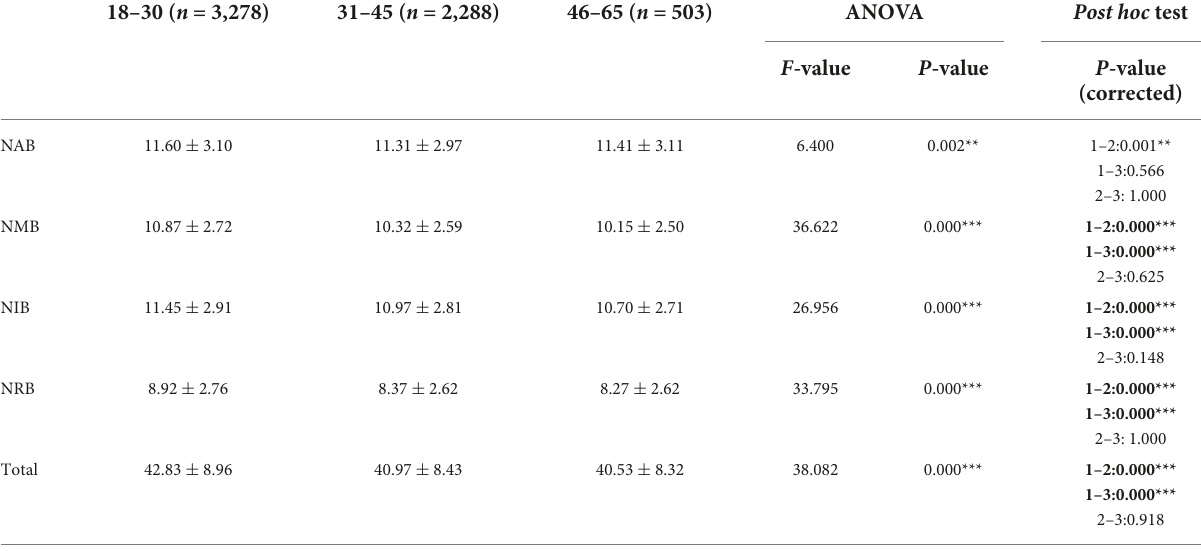
TABLE 10 Results for age differences in negative cognitive processing bias scale